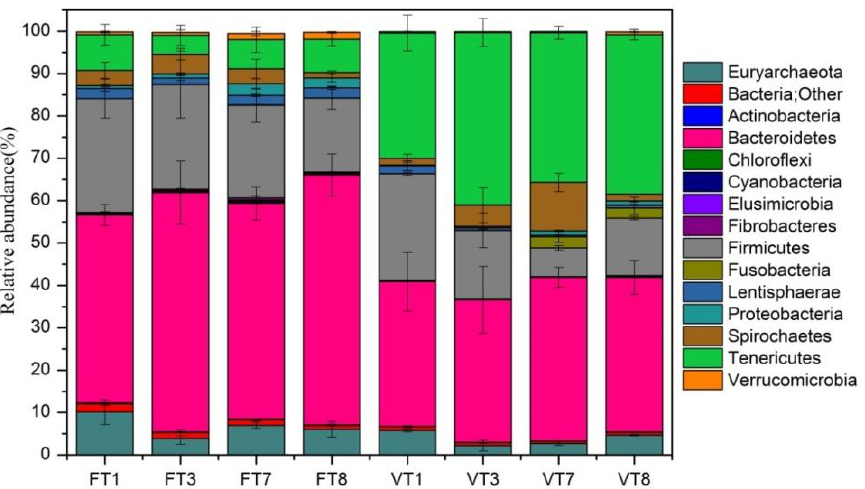
Figure 3. The relative abundance of prokaryotic phyla in 14 mmol/L disodium fumarate (DF) groups (FT3 and VT3), 80 mg/kg monensin sodium salt (MSS) groups (FT7 and VT7), 7 mmol/L DF